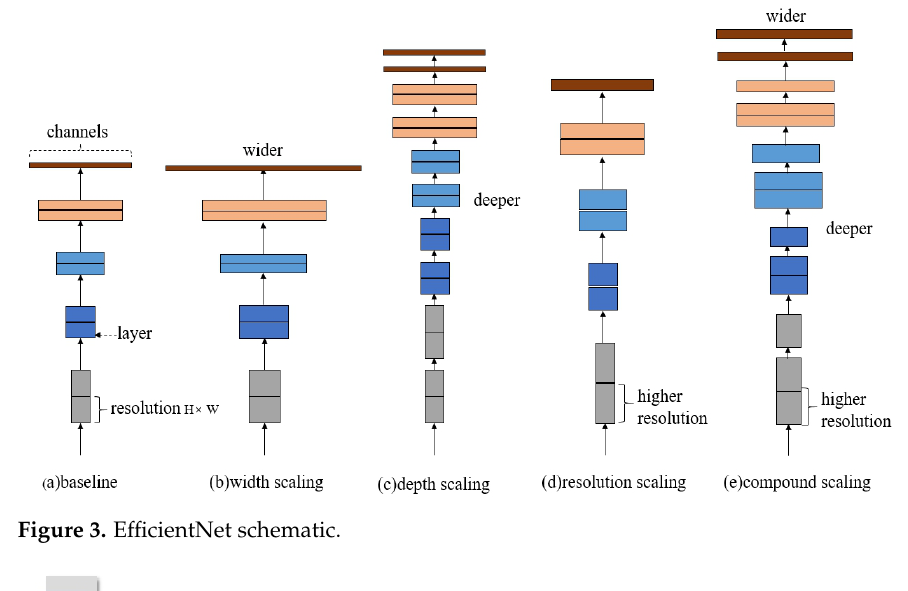
Figure 3. EfficientNet schematic.